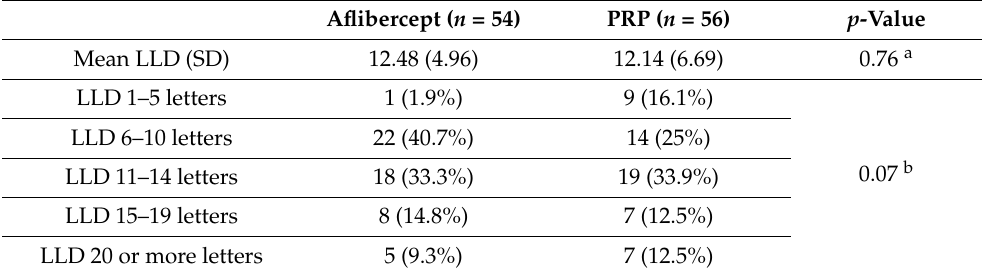
Table 2. LLD difference between treatment naive arms at 52 weeks.